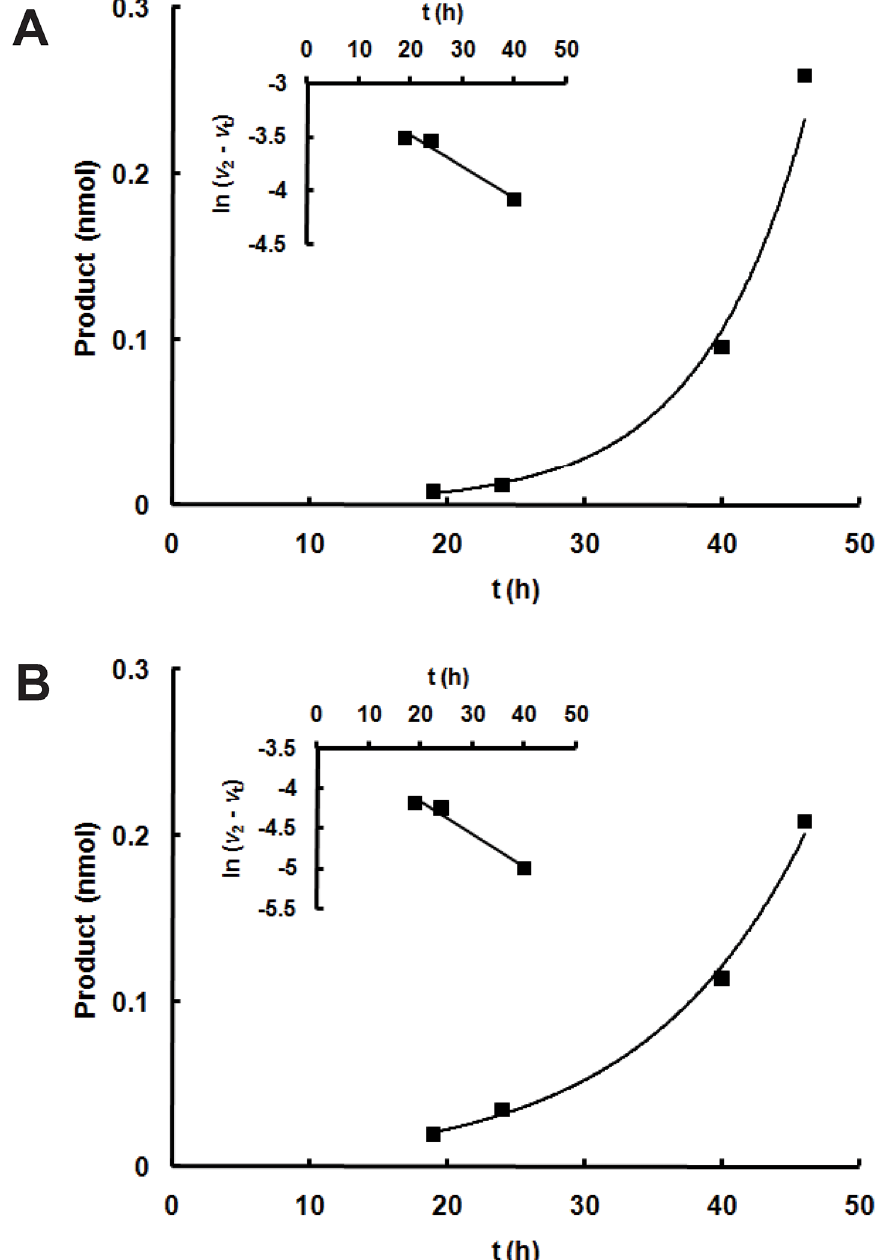
Fig 2. Enzyme activity assay of Sf β gly-N and Sf β gly-C showing an activation process. Purified samples of Sf β gly-N (A) and Sf β gly-C (B) in 100 mM citrate-phosphate buffer, pH 6.0, were incubated with substrate 1 mM methylumbelliferyl β -glucoside prepared in 100 mM citrate-phosphate buffer, pH 6.0, for 16, 22, 40 and 48 h. The fluorescence of the product methylumbelliferone (excitation, 360 nm; emission, 450 nm) was determined after the addition of 100 mM glycine-NaOH, pH 10.5. Inserts: rates were analyzed according the hysteresis model [10]. The reaction rate at each time ( v t ) was calculated based on the slope at that specific time. The slope at 48 h was taken as the final rate ( v 2